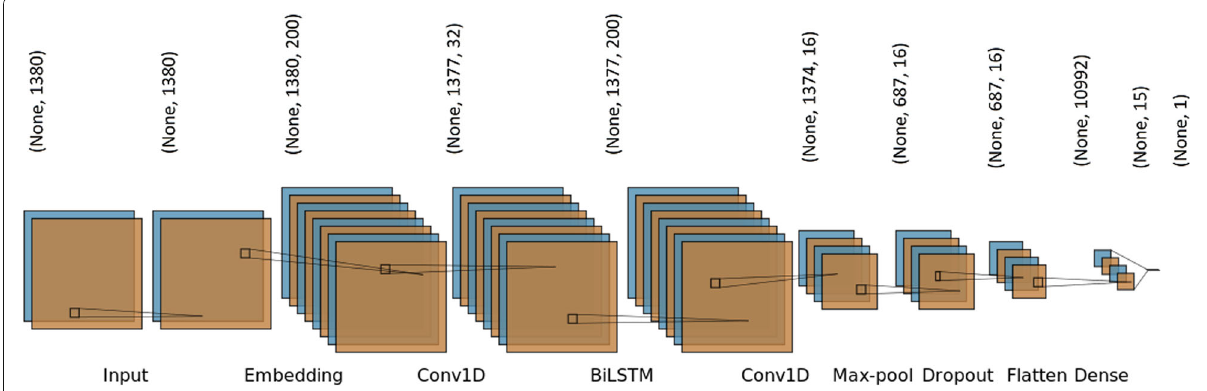
Fig. 2 The proposed model for sentiment analysis